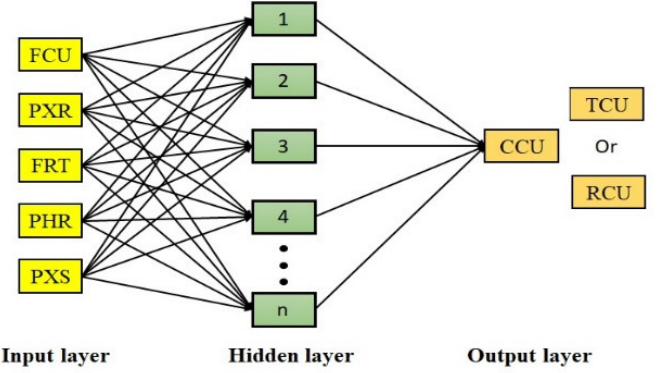
Figure 13. The structure of the NN models for the prediction of CCU, RCU and TCU from the industrial flotation plant.